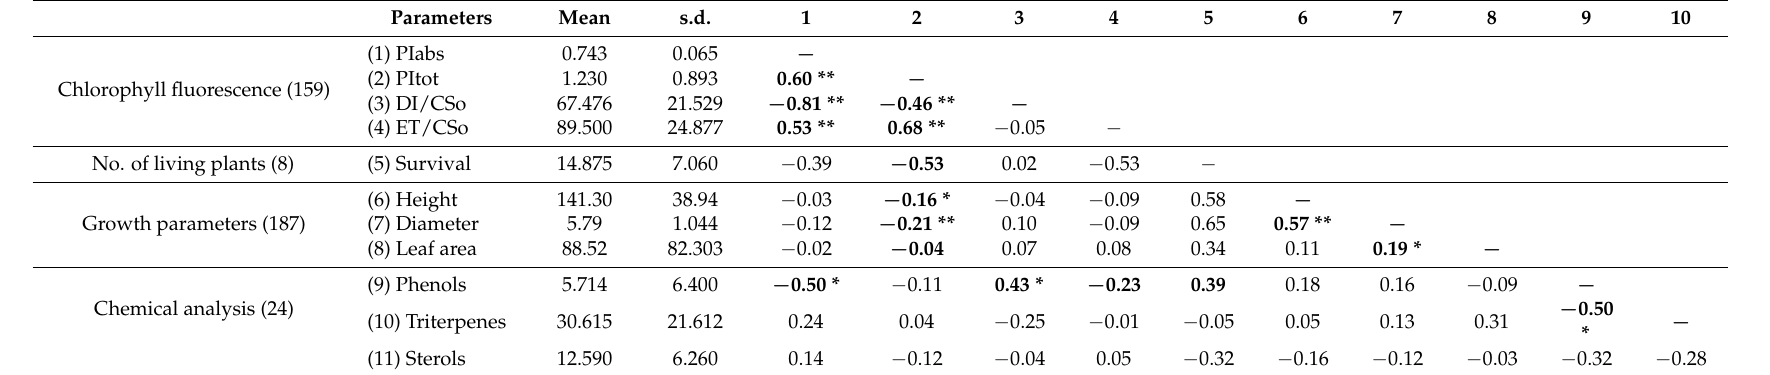
Table 4. Spearman rank-based correlation matrix for the interaction of the 11 selected parameters.